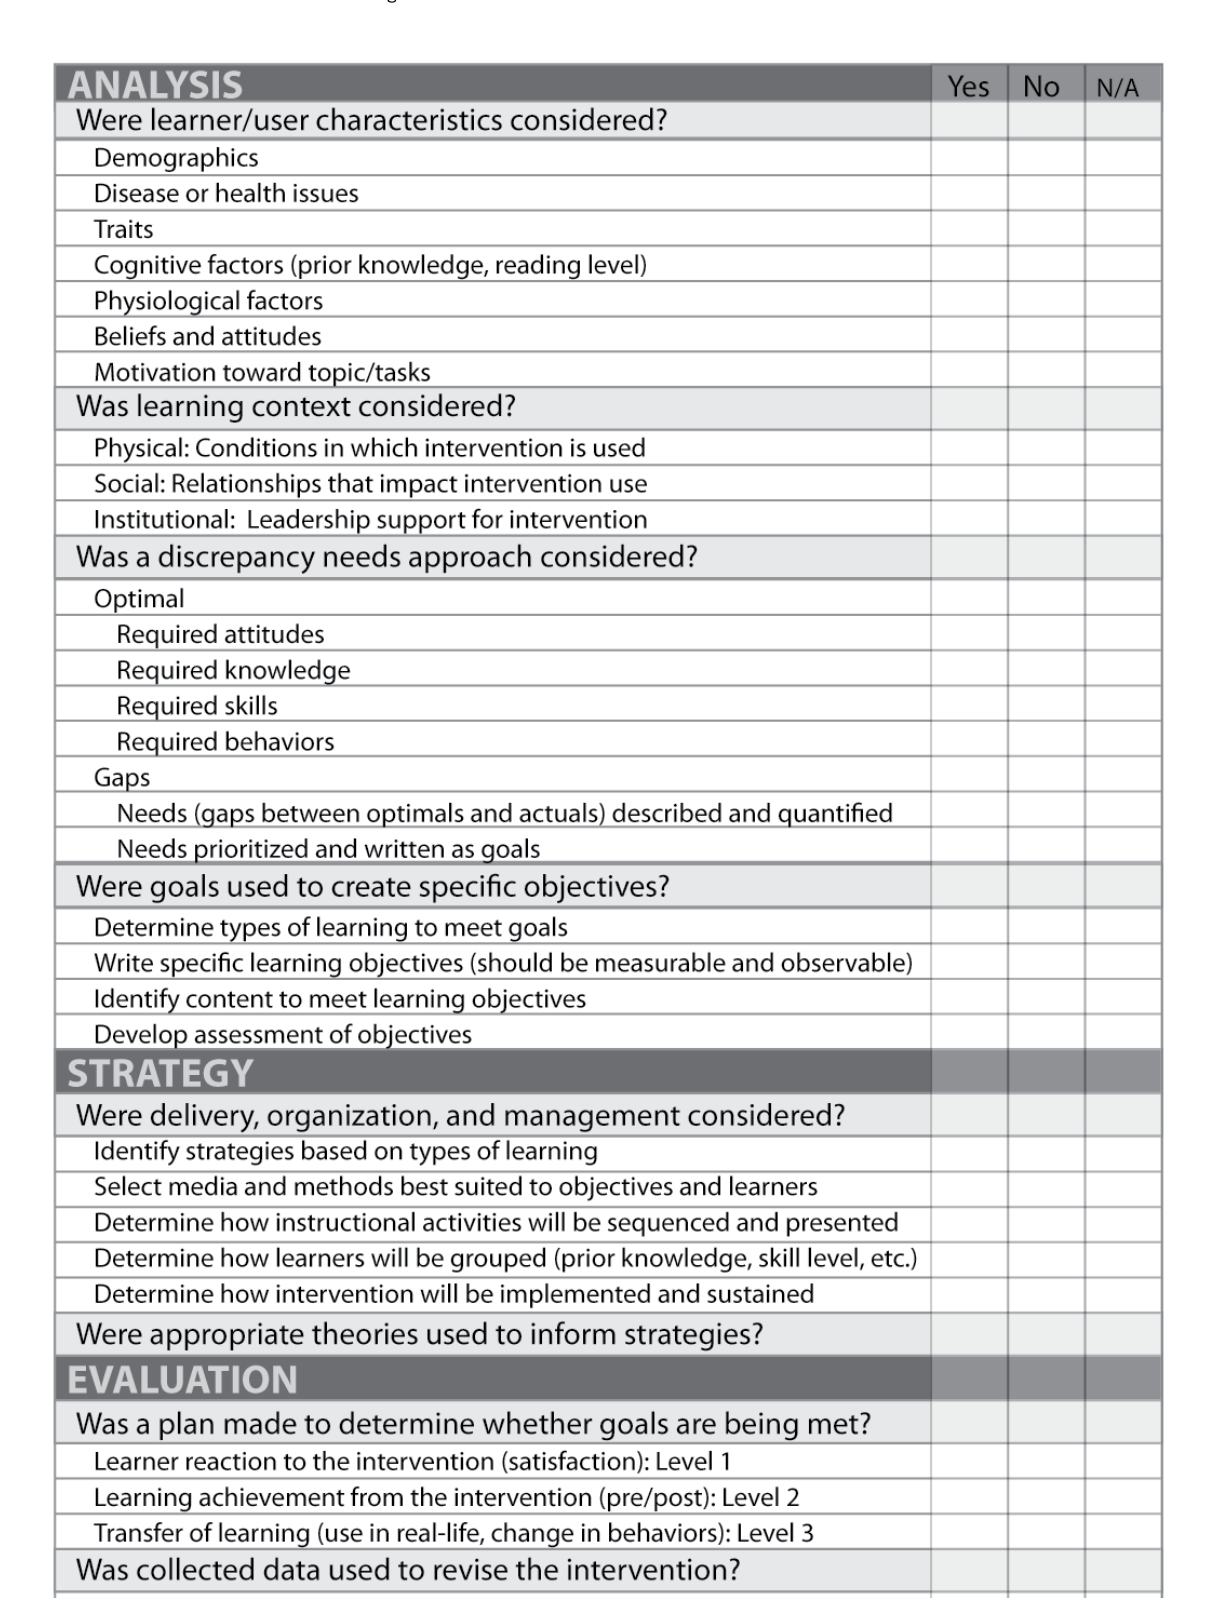
Figure 8. Internet intervention instructional design check